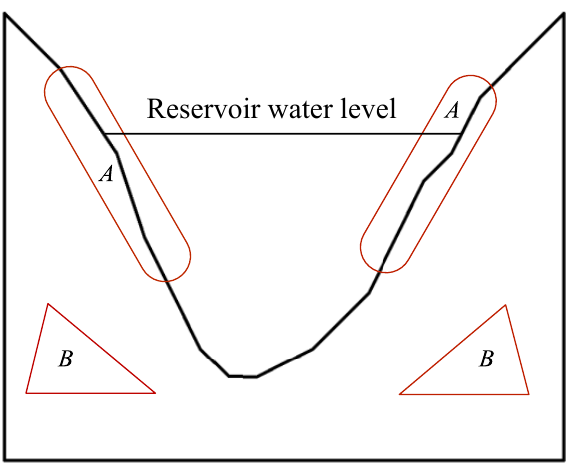
Figure 3. Diagram of a super-high arch dam valley’s cross-section. (3) Unsaturated seepage–stress coupling mechanism in fractured rock masses After the initial water storage, the rock mass of the reservoir bank will undergo a tran- sition from unsaturated seepage to saturated seepage, causing deformation of the rock mass. After the fractal system with different sizes and random distributions is homogenized, the fractured rock mass can be regarded as an equivalent continuous porous medium. Under unsaturated and non-steady flow conditions, the seepage–stress coupling mechanism of the rock mass is described as